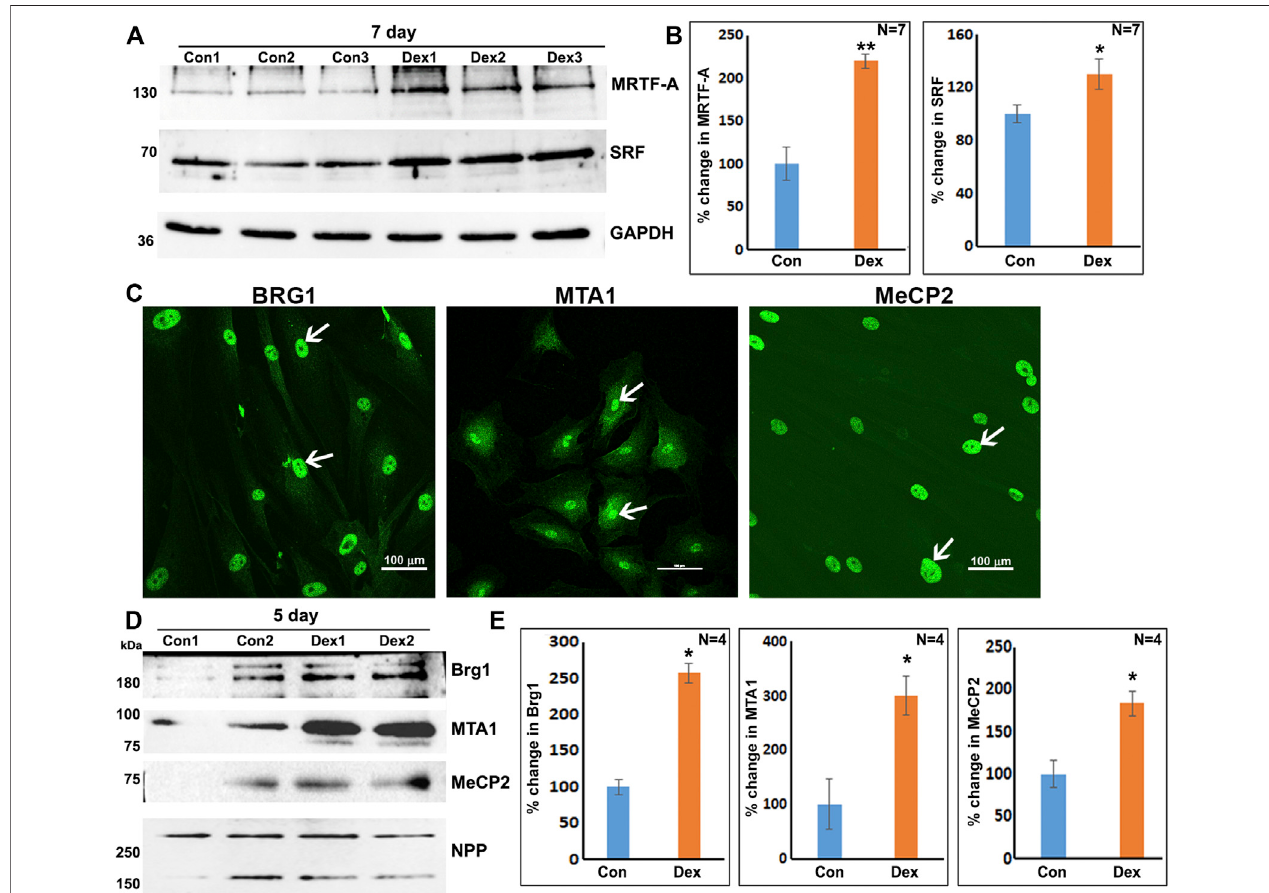
FIGURE7| Increasedlevelsoftranscriptional(SRF,MRTF-A) andchromatin regulators(BRG1, MTA1,and MeCP2)inDextreatedhumanTMcells. (A,B) Totalcell lysates derived from Dex treated (7 days) TM cells showed a signi fi cant increase in the levels of SRF and MRTF-A relative to controls. (C) Nuclear distribution of BRG1, MTA1, and MeCP2 in human TM cells. (D,E) Increased levels of BRG1, MTA1, and MeCP2 proteins in the nuclear protein fraction of Dex treated (5 days) TM cells. * p < 0.05; ** p < 0.01. Scale bars indicate image magni fi cation.